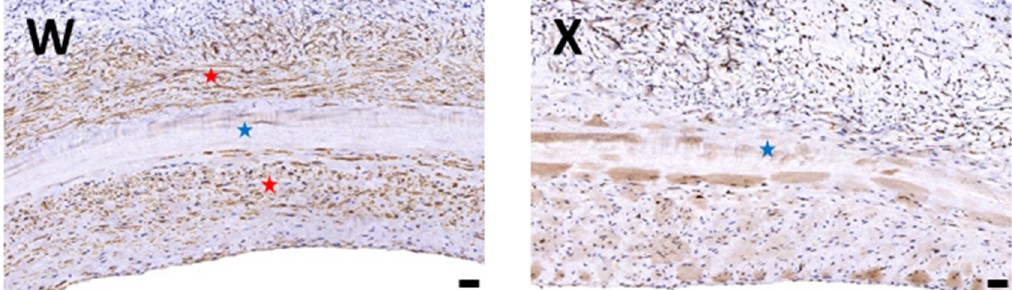
Figure 7. H&E and IHC staining of the explanted grafts at day-30 and day-90. ( A – L ) day-3; ( M – X ) day-90; ( A , G , M , S ) H&E; ( B , H , N , T ) CD31; ( C , I , O , U ) vWF; ( D , J , P , V ) eNOS; ( E , K , Q , W ) α -SMA; ( F , L , R , X ) CD45; Red arrow heads in ( T , U , V ) indicated endothelial cells at inner surface, while red stars marked in W indicated α -SMA-stained cells around sDHUA at day-90. The blue stars indicated sDHUA site. Magnification: ( A – F ), ( M – R ) 40 × , Scale bar = 200 µ m; ( G – L , S – X ) 200 × , Scale bar = 50 µ m.